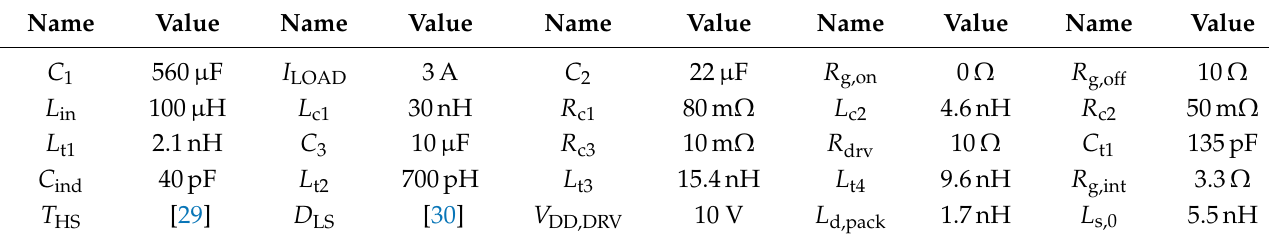
Table 1. Parameter values of the simulated converter.